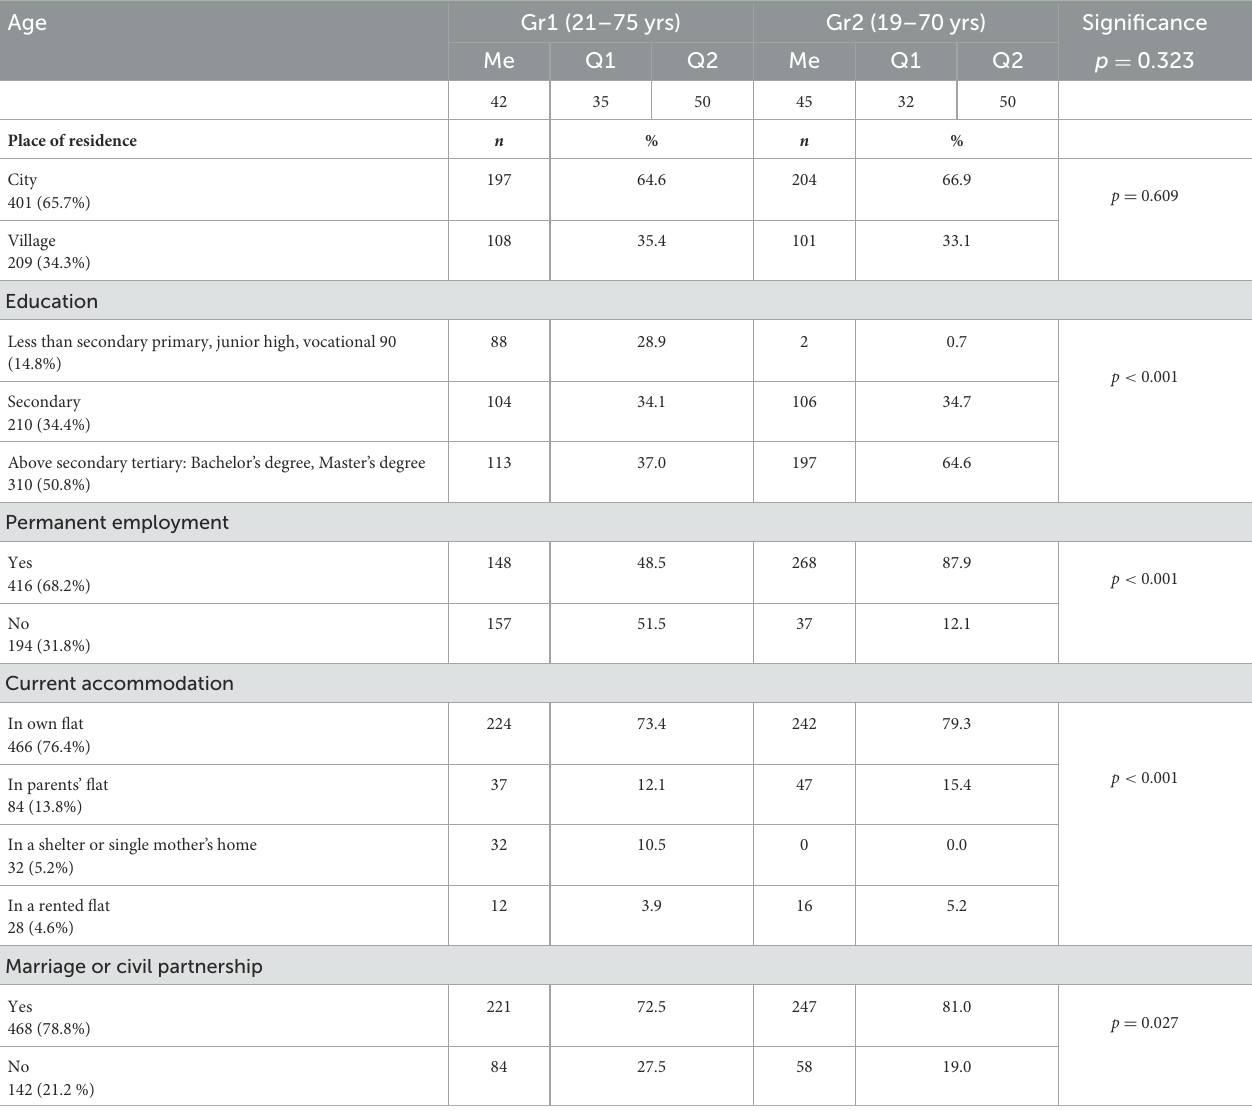
TABLE 2 Violence experienced in the past—in the family home of participants. Violence in the Gr1 Gr2 family home